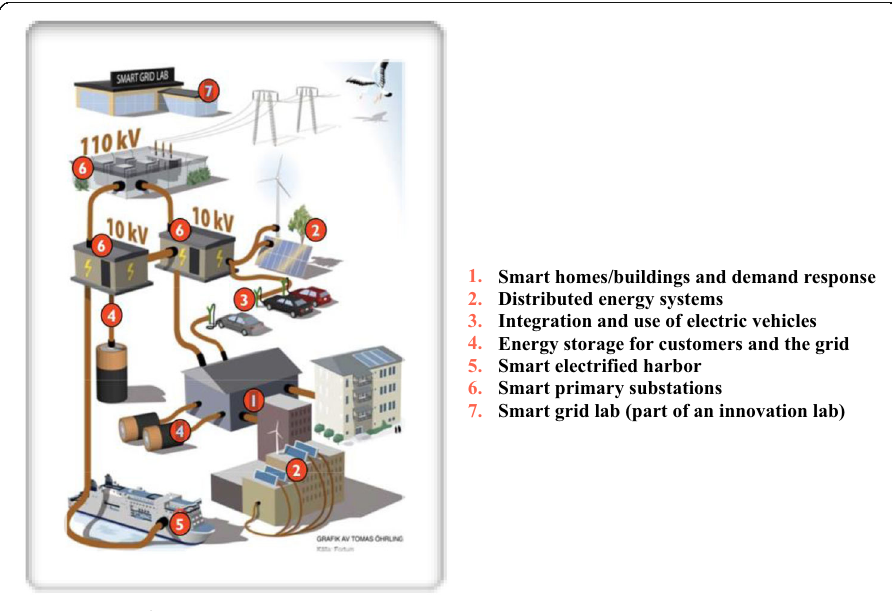
Fig. 4 Smart grid system in